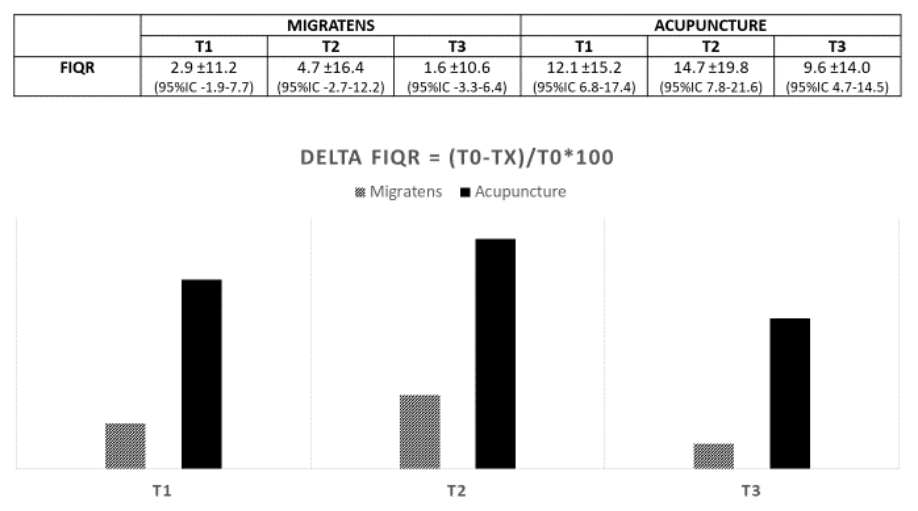
Figure 7. Reduction difference in FIQ-R values in the two treatment groups during observation (values are expressed as mean difference ± SD).